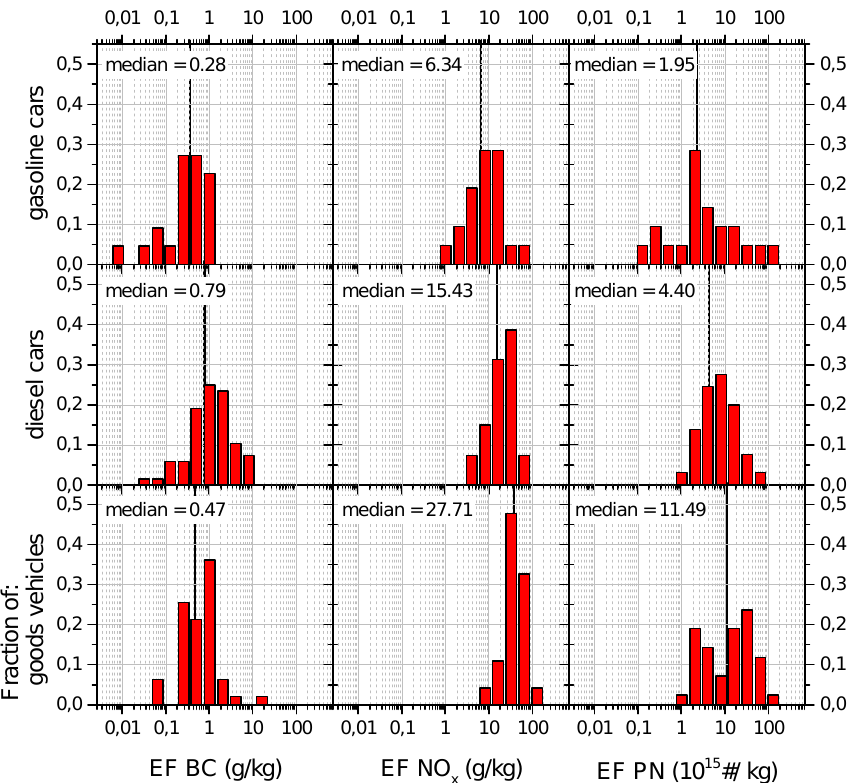
Figure 2. Black carbon (BC), particle number concentration (PN) and NO x emission factor (EF) distributions for gasoline and diesel cars, light and heavy goods vehicles. Note the EF logarithmic